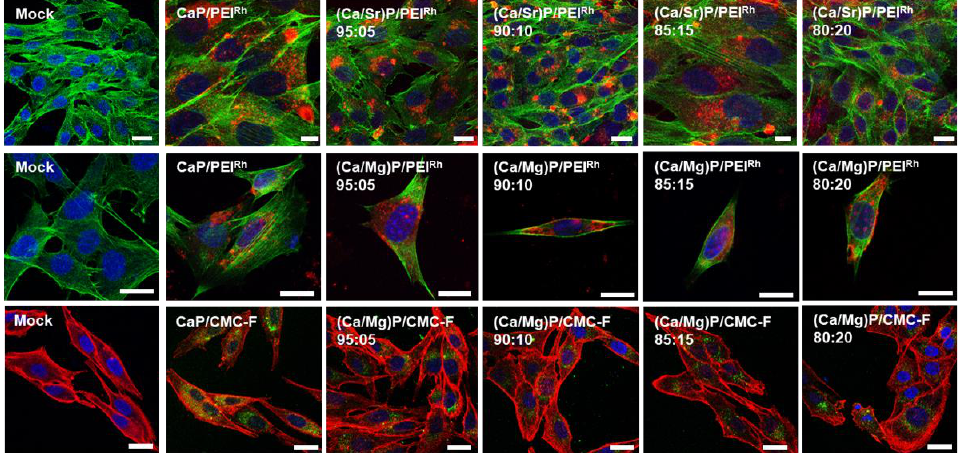
Figure 7. Confocal laser scanning microscopy of HeLa cells after incubation with nanoparticles for 24 h. Top row: Undoped calcium phosphate and strontium-doped calcium phosphate nanoparticles labelled with PEI Rh . Blue: cell nucleus (Hoechst33342); green: cytoskeleton (actin with AlexaFluor ® -488 phalloidin); and red: PEI Rh -labelled nanoparticles. Middle row: calcium phosphate and magnesium-doped nanoparticles labelled with PEI Rh . Blue: cell nucleus (Hoechst33342); green: cytoskeleton (actin with AlexaFluor ® -488 phalloidin); and red: PEI Rh -labelled nanoparticles. Bottom row: calcium phosphate and magnesium-doped nanoparticles labelled with CMC-F. Blue: dell nucleus (Hoechst33342); red: dytoskeleton (actin with AlexaFluor ® -647 phalloidin); and green: CMC-F-labelled nanoparticles. Control: untreated cells (mock). Scale bars: 20 µm.